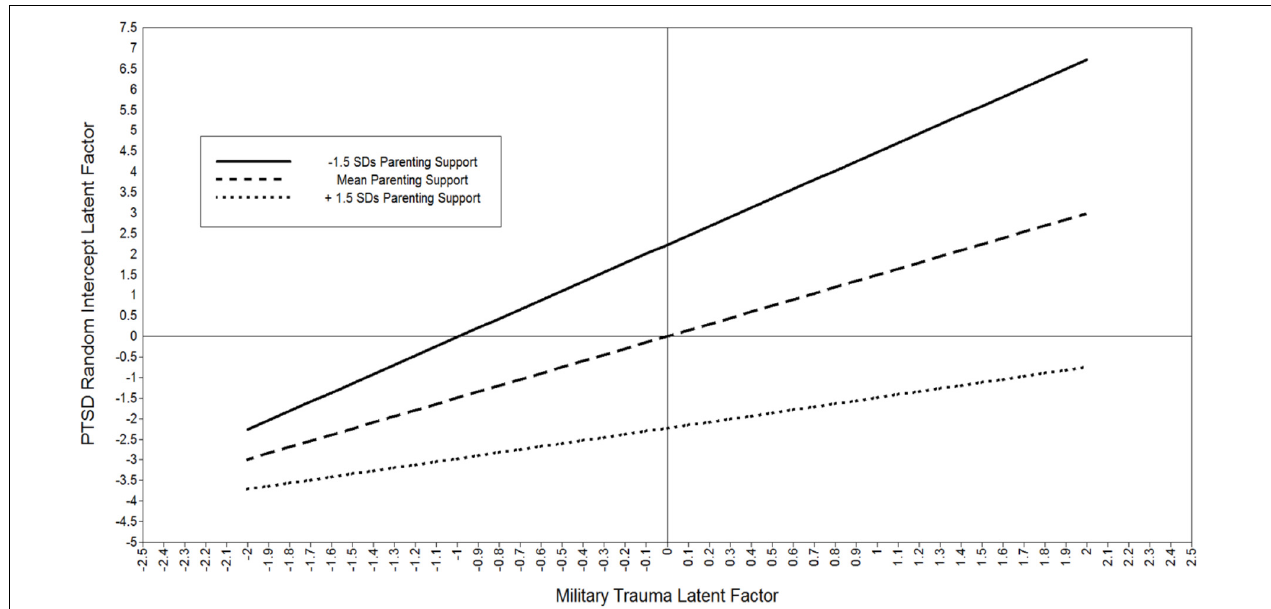
FIGURE 4 | Plot of moderating effect of parenting support on the negative impact of trauma on PTSD symptoms for military fathers. Both the trauma factor and PTSD factor are centered latent variables; zero represents the factor mean. The estimated “region of significance” and bootstrapped confidence intervals indicated that parenting support reduced trauma’s impact starting at 1.4 standard deviations of support for fathers. That is, above 1.4 standard deviations there is a non-significant effect of Trauma on PTSD.